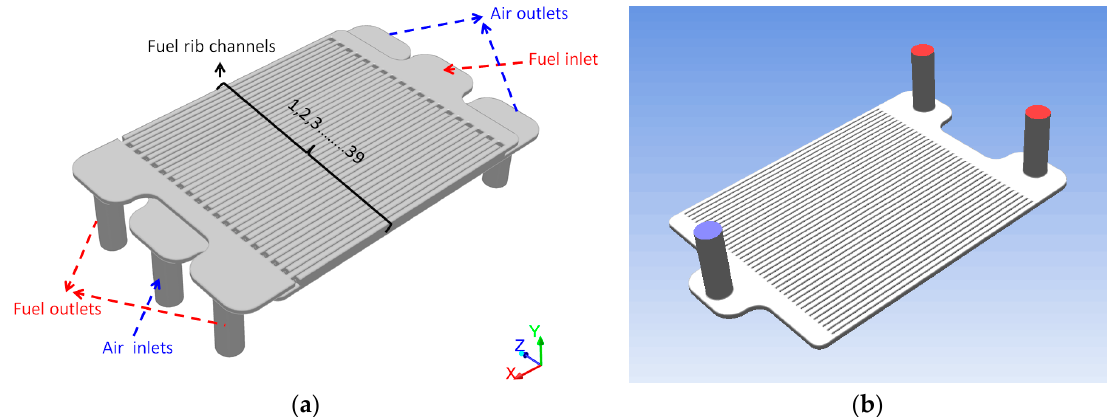
Figure 1. ( a ) Schematic diagram of the typical one-cell solid oxide fuel cell (SOFC) stack model with an interdigital fuel flow rib channel design; ( b ) The conventional air flow rib channels with parallel line-type configuration.